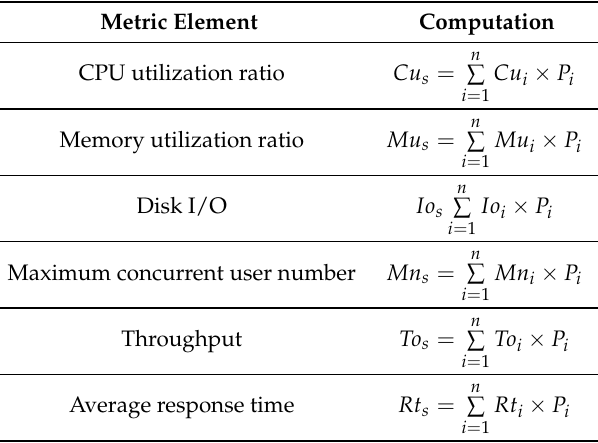
Figure 3. The choice relation system. Table 5. The computation of the choice relation system.